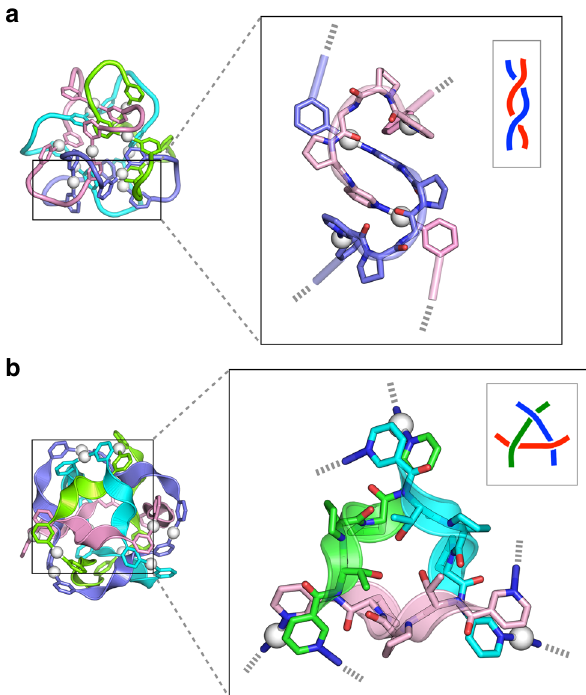
Fig. 6 Structural origins of the molecular entanglements observed in [4] 12 - catenanes. a T 2 -edge geometry induced by interlocked Ω -shaped loops of 1 extracted from the crystal structure of [4] 12 -catenane 2 16 . b Three-crossed geometry induced by the P II -helical conformation of 3 observed in the crystal structure of [4] 12 -catenane 4 . Peptide regions are highlighted as cartoon representations. Hydrogen atoms, counter anions, and solvents have been omitted for